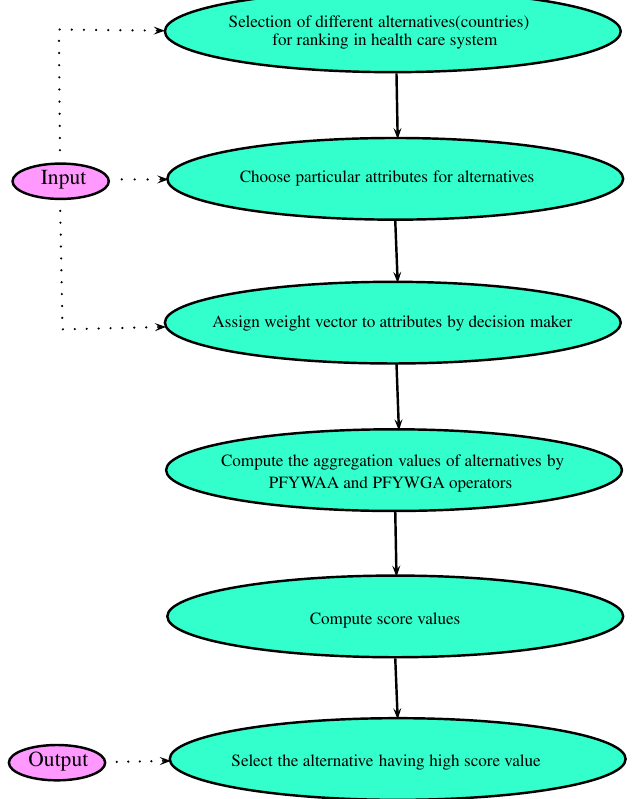
Figure 1. Flow chart to select high rank country in health care